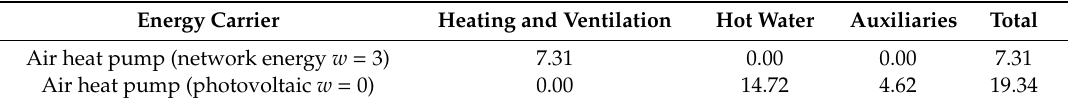
Table 15. The annual final energy demand (kWh / (m 2 · year)) for the multi-family building at Akacjowa Street in Goleniow (ground source heat pump with photovoltaic installation).